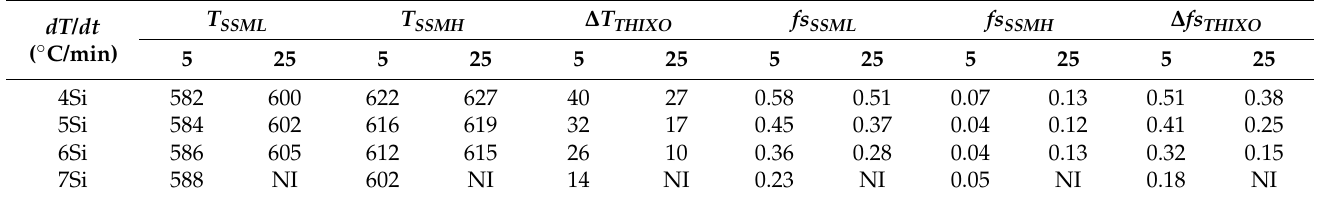
Table 9. Thixoforming working window temperatures (in ◦ C) and solid fractions (in mass fraction) for the Al-Si-Zn alloys studied here for 20 mg samples. Values that were not identified are shown as